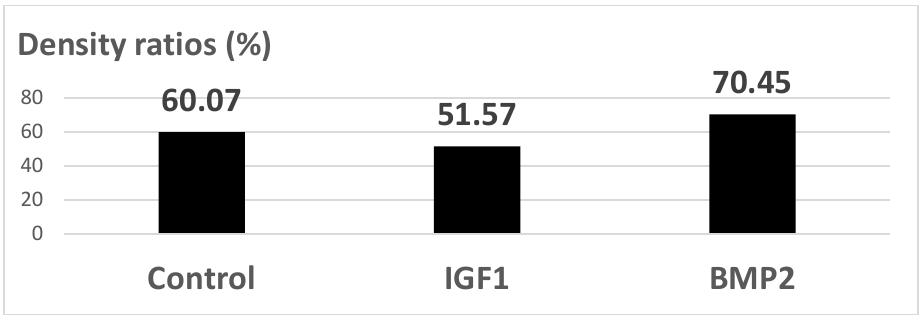
Figure 18. Relative density of tissue adjacent to samples vs. porous Ti density ratios [%], as seen by numerical analysis performed on MicroCT images.